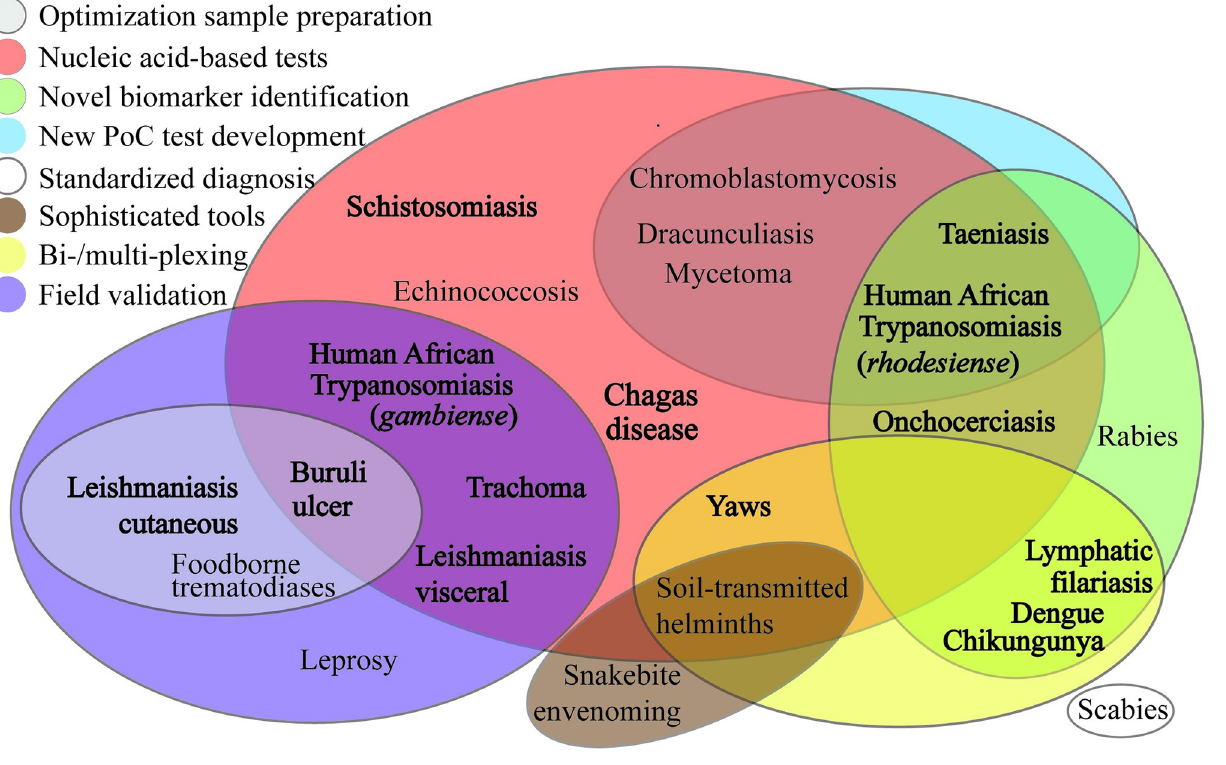
Fig 3. Venn diagram depicting the PoC implementation needs for various NTDs. After reviewing the 24 NTDs (see Supporting information and Table 1), NTDs were placed in the colored circles based on their PoC implementation need. The legends indicate the particular diagnostic need of the NTD. NTDs in bold depict priority for PoC diagnoses as set in WHO’s 2021–2030 roadmap [8]. NTD, neglected tropical disease; PoC, point-of-care; WHO, World Health Organization.